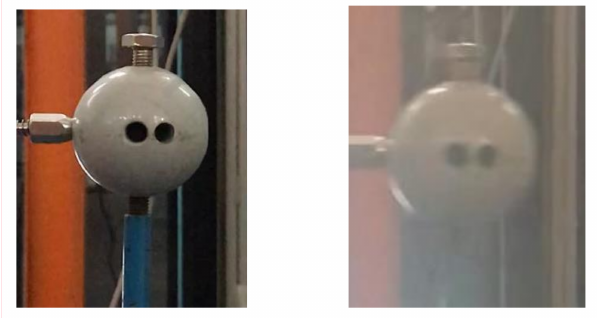
Figure 11. Comparison of fog